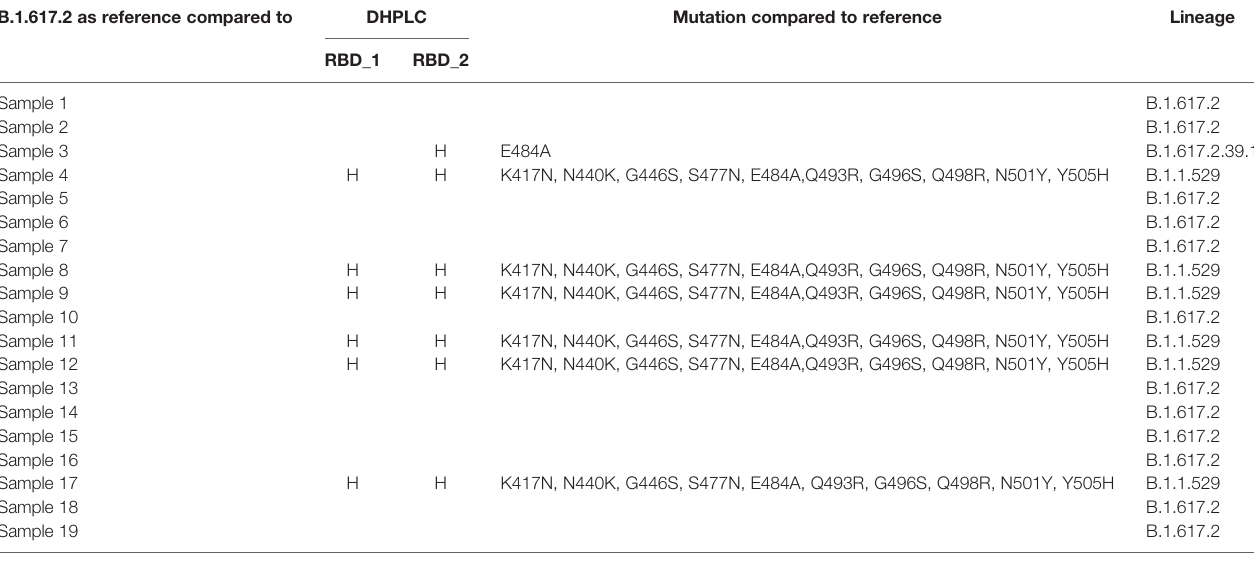
TABLE 2 | Complete fi ndings of the blind-label group using B.1.617.2 as reference against unknown positive